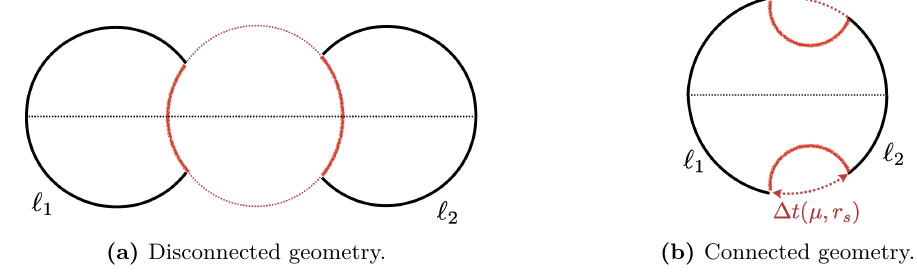
Figure 2. The geometries contributing to (3.8). Here ‘ 1 and ‘ 2 are the lengths of one half (i.e., the “ket” part) of the Euclidean boundaries. The solid black lines are the AdS boundaries, and the red solid lines represent the ETW branes. The dashed red lines have no relevance in this picture, but will complete index loops in section